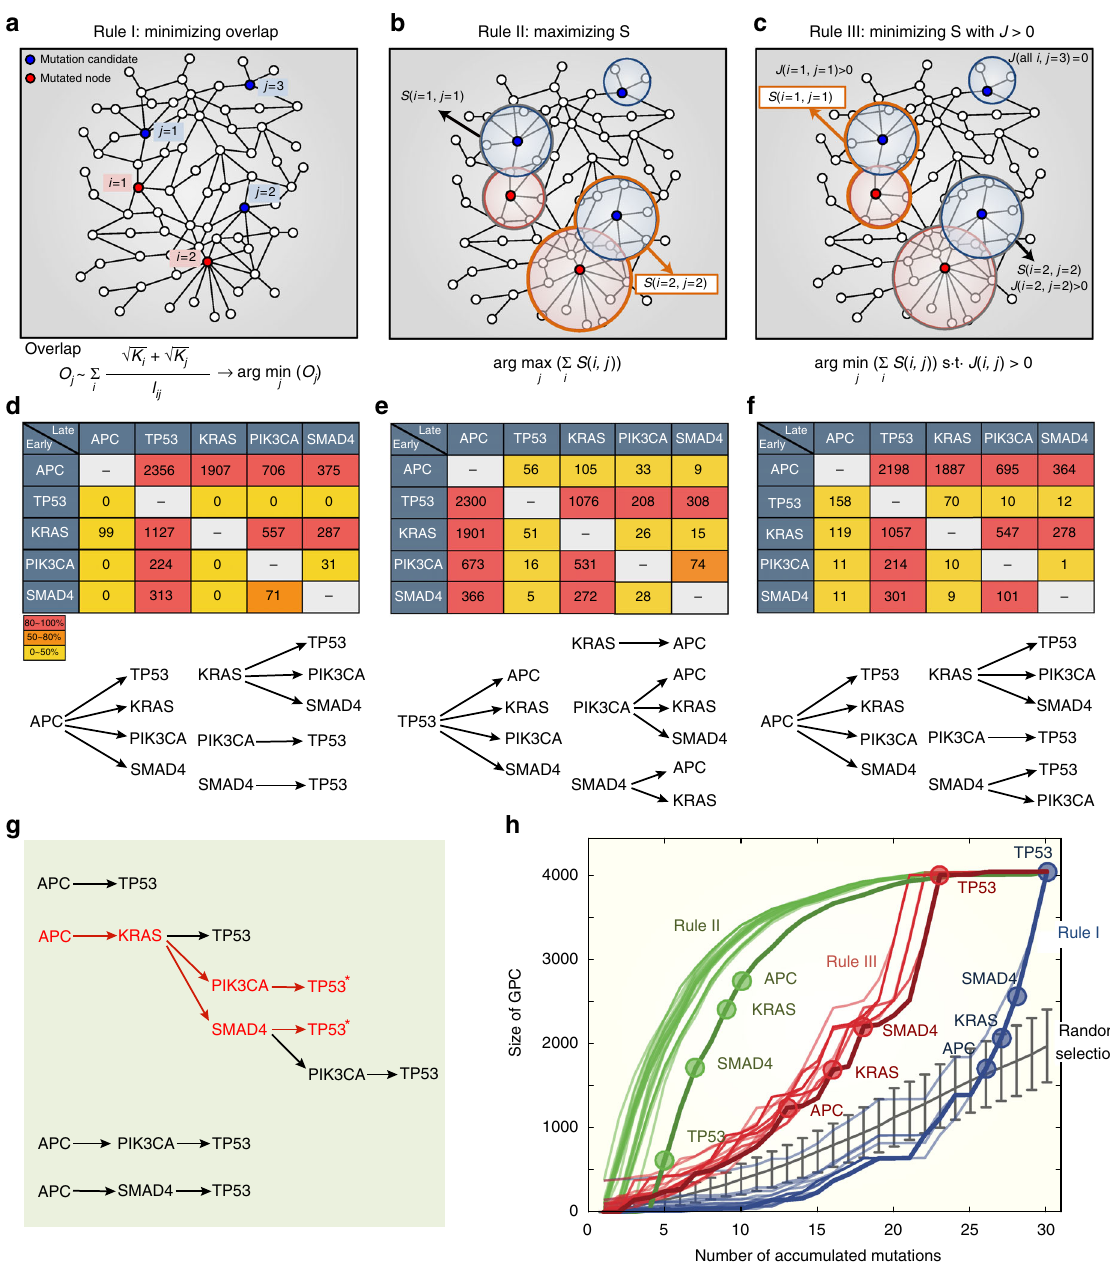
Fig. 5 Percolation transition of a GPC. a A mutation selection rule for minimizing the degree of overlap between somatic mutations (see Methods